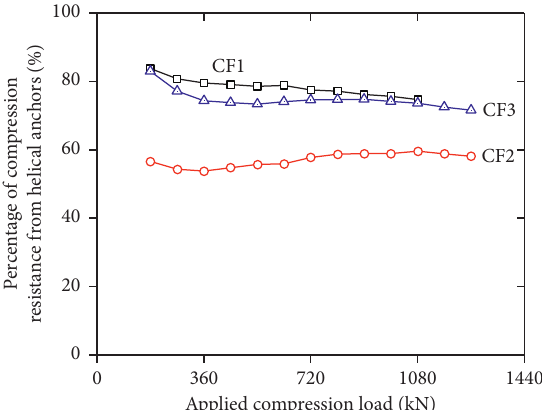
Figure 9: Variation in percentage of compression resistance from the helical anchors underneath